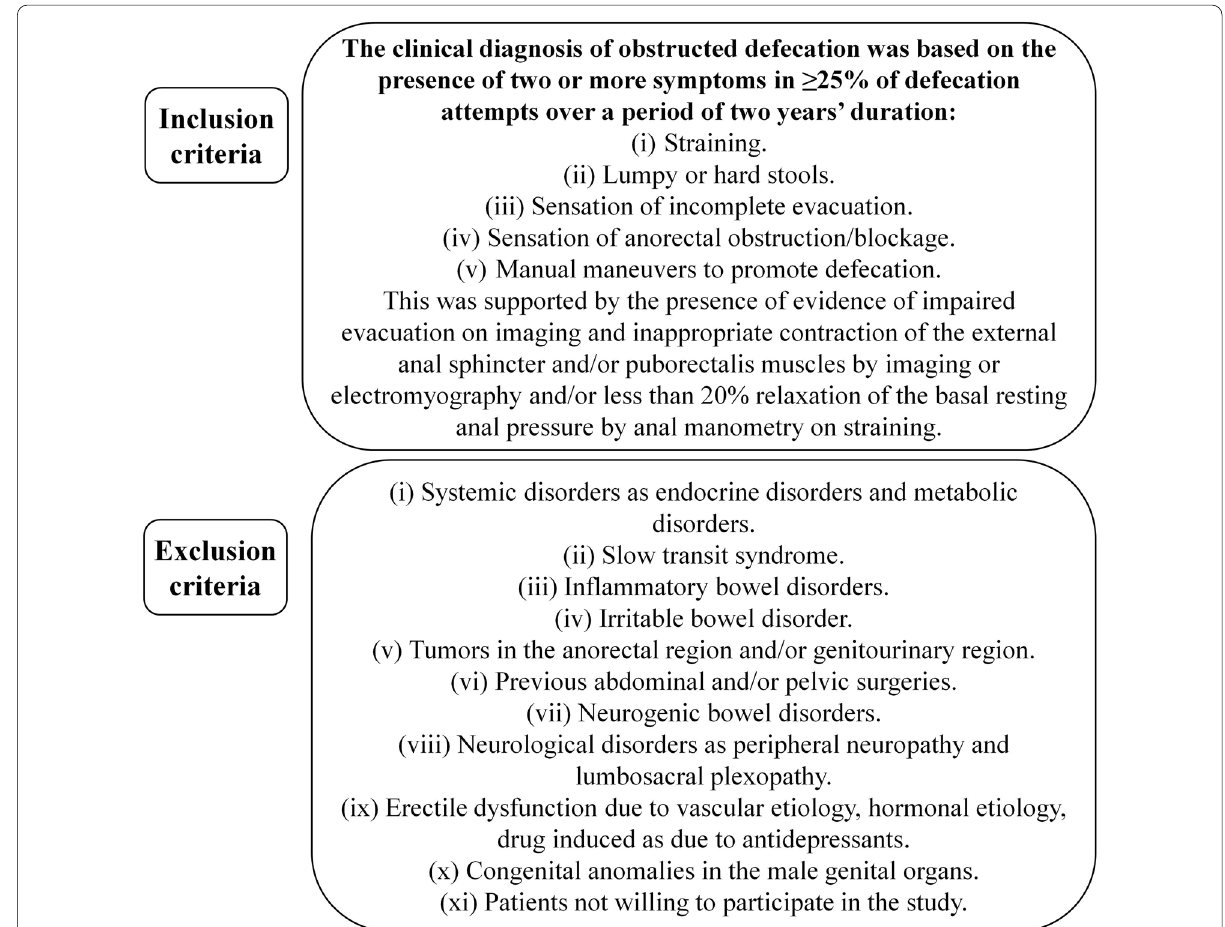
Fig. 1 Inclusion and exclusion criteria of the research [3, 6, 14, 19,